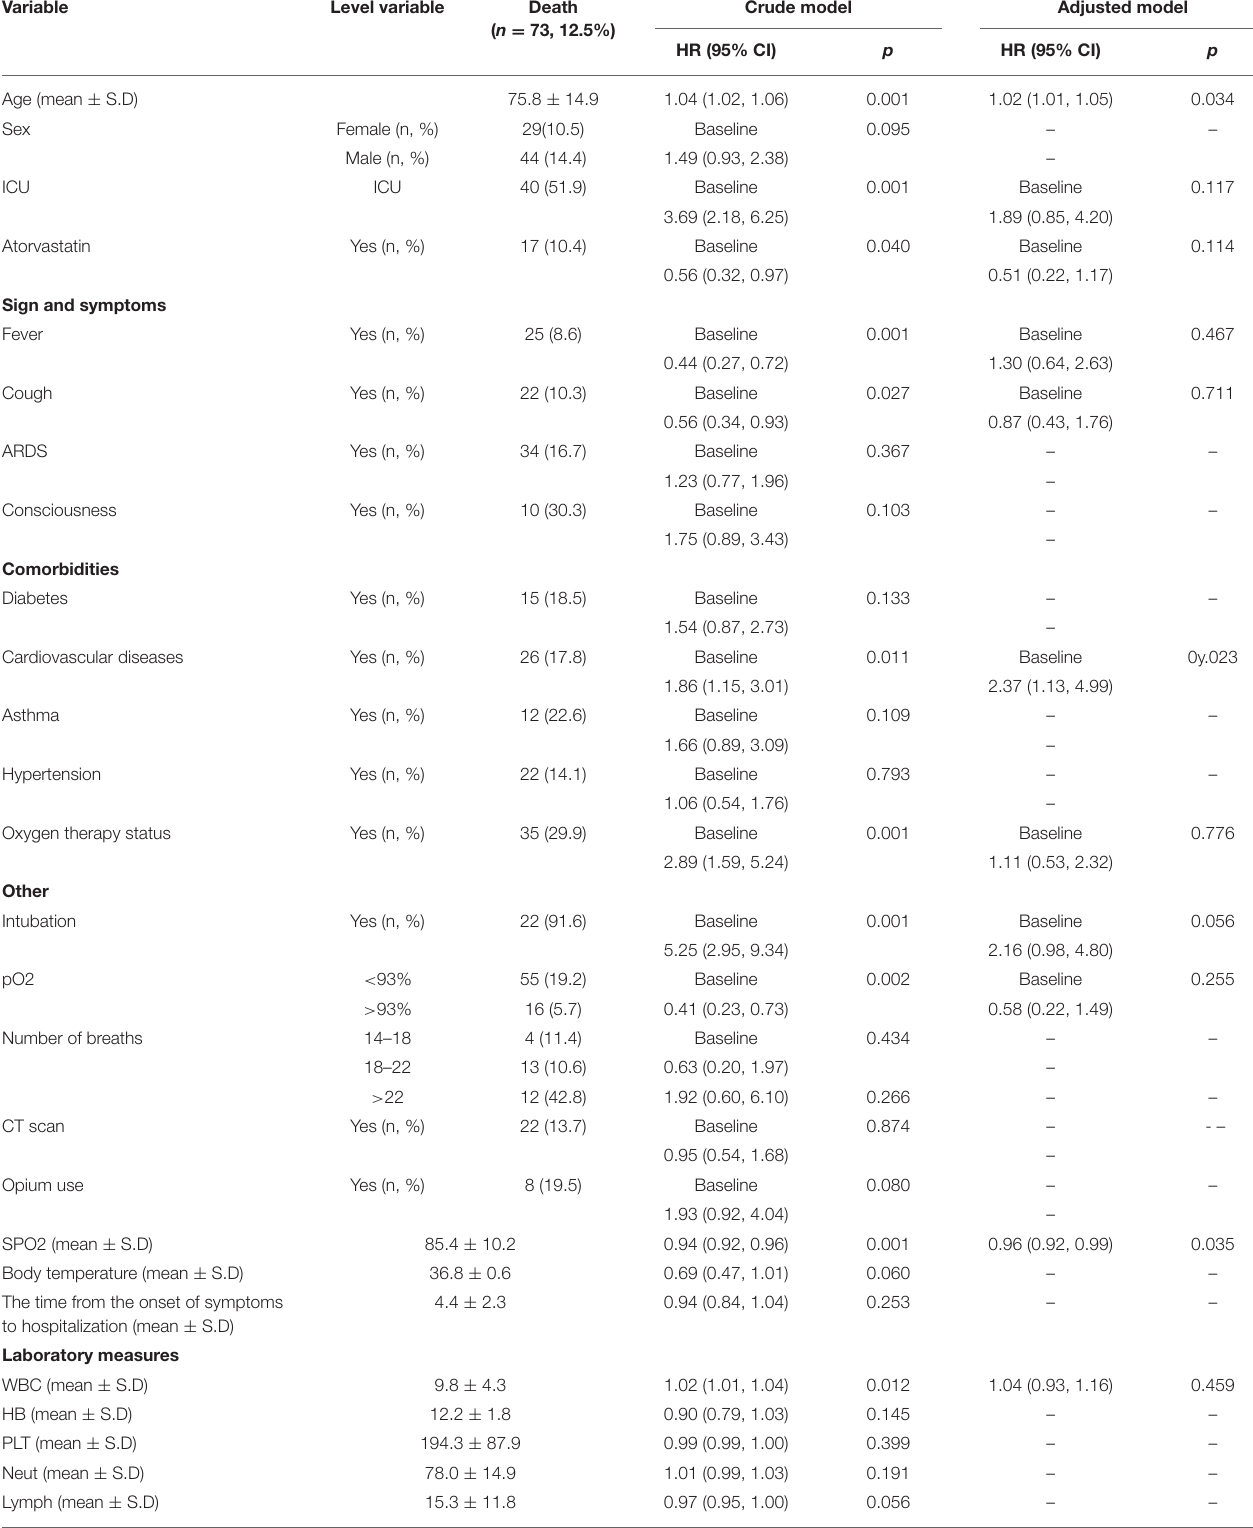
TABLE 2 | Data analysis using the crude and adjusted Cox regression models considering mortality as a single outcome.